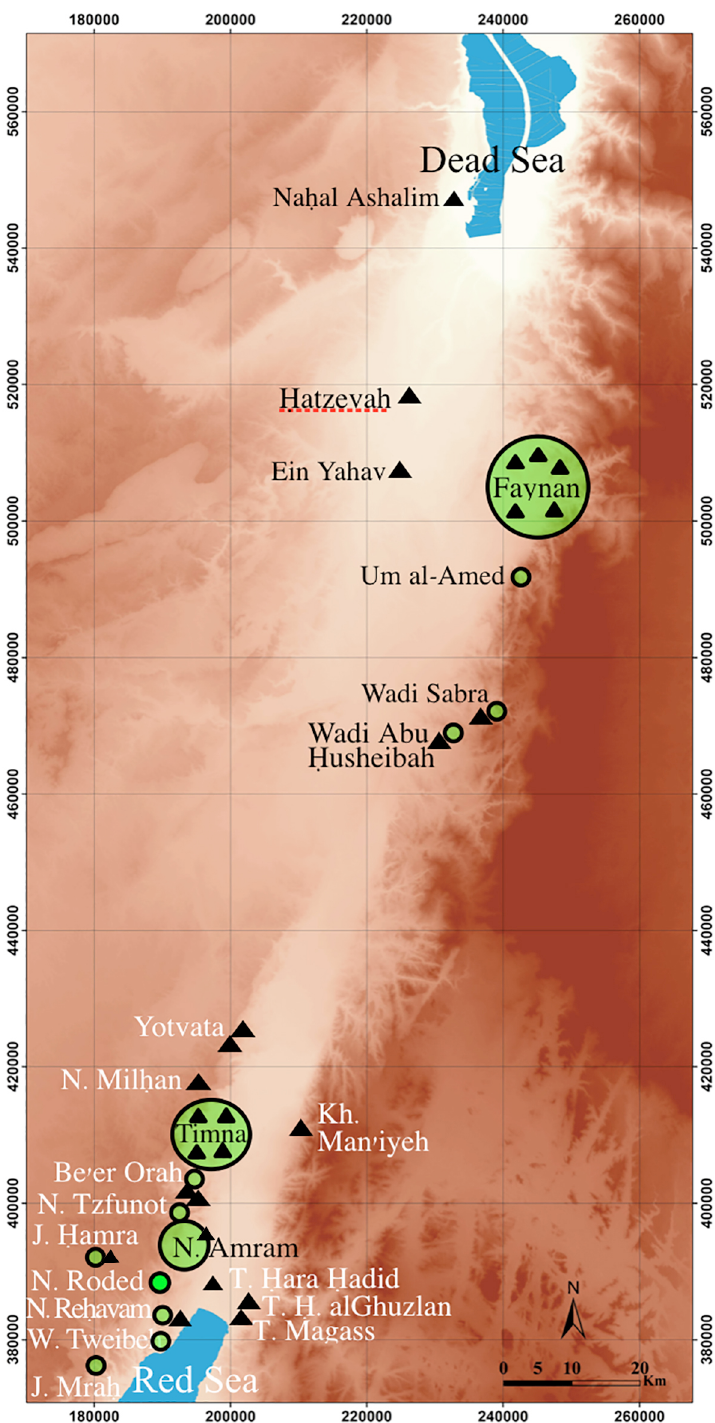
Figure 4 Map of the ‘Arabah copper mines and production sites, from Chalcolithic to Early Islamic periods. Green spots indicate copper mines, black triangles are smelting